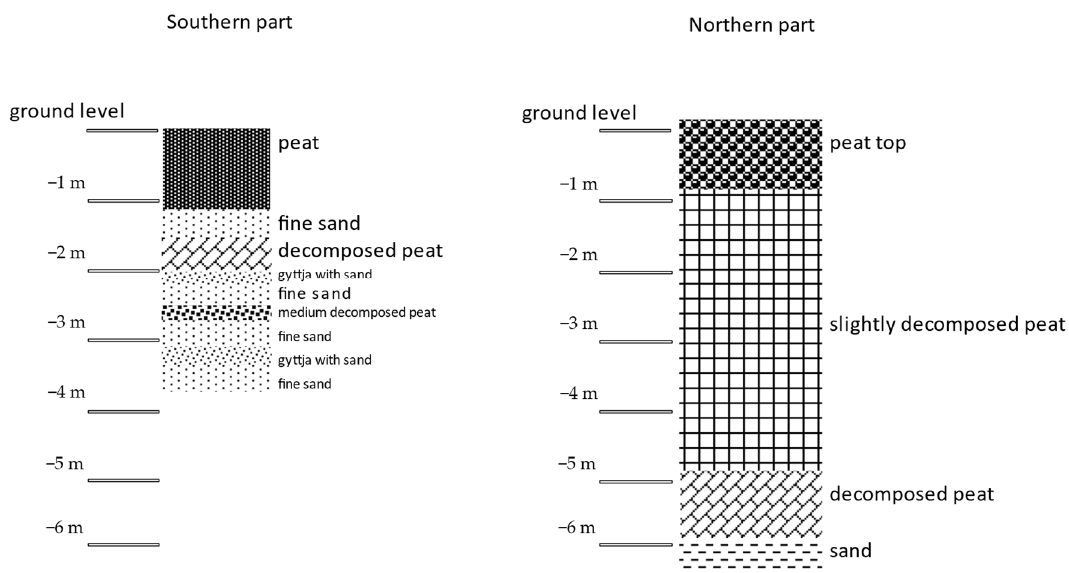
Figure 2. Stratigraphic column of the Raduszyn reservoir before peat excavation.